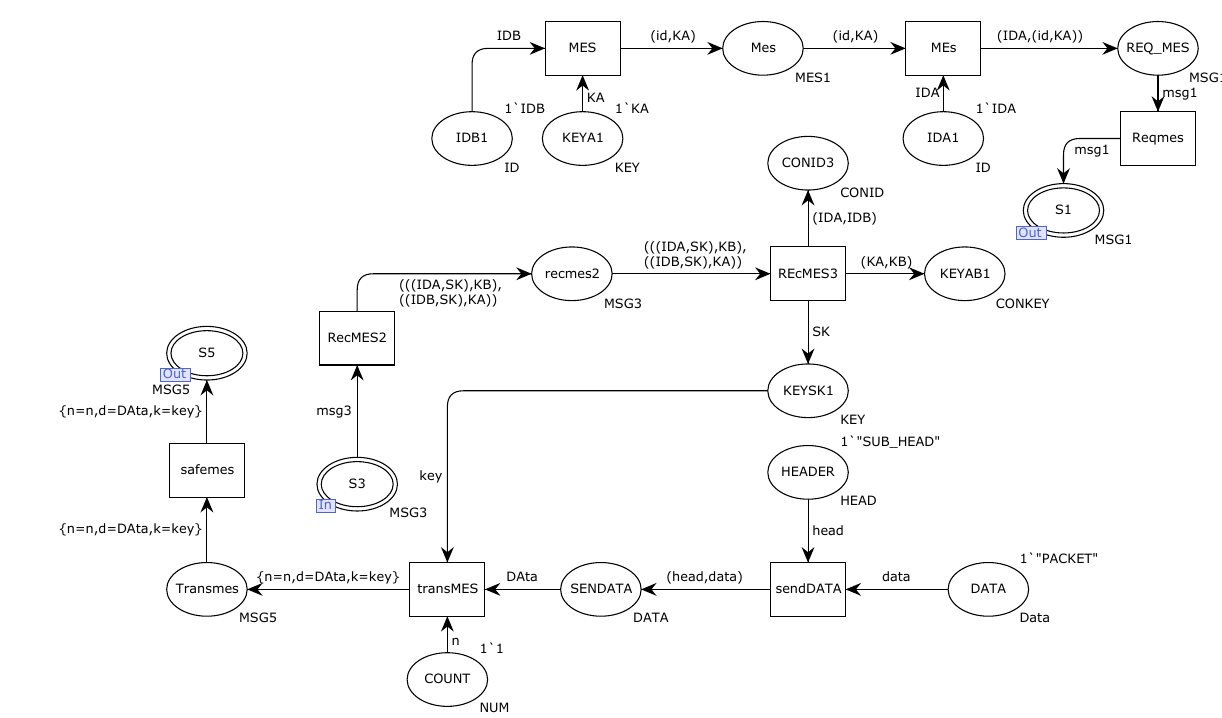
Figure 5. Internal model of alternative variation